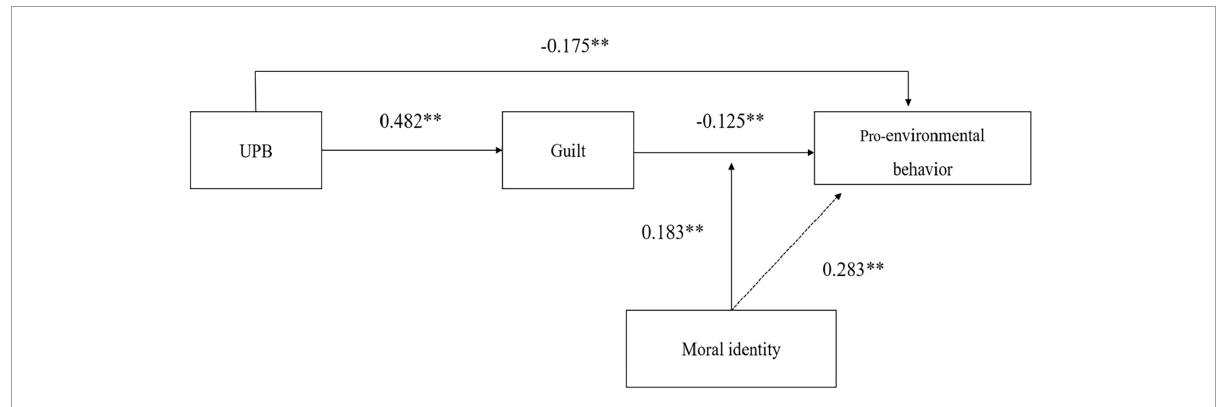
FIGURE2 Results of the research model. ∗∗ p < 0.01, * p < 0.05.